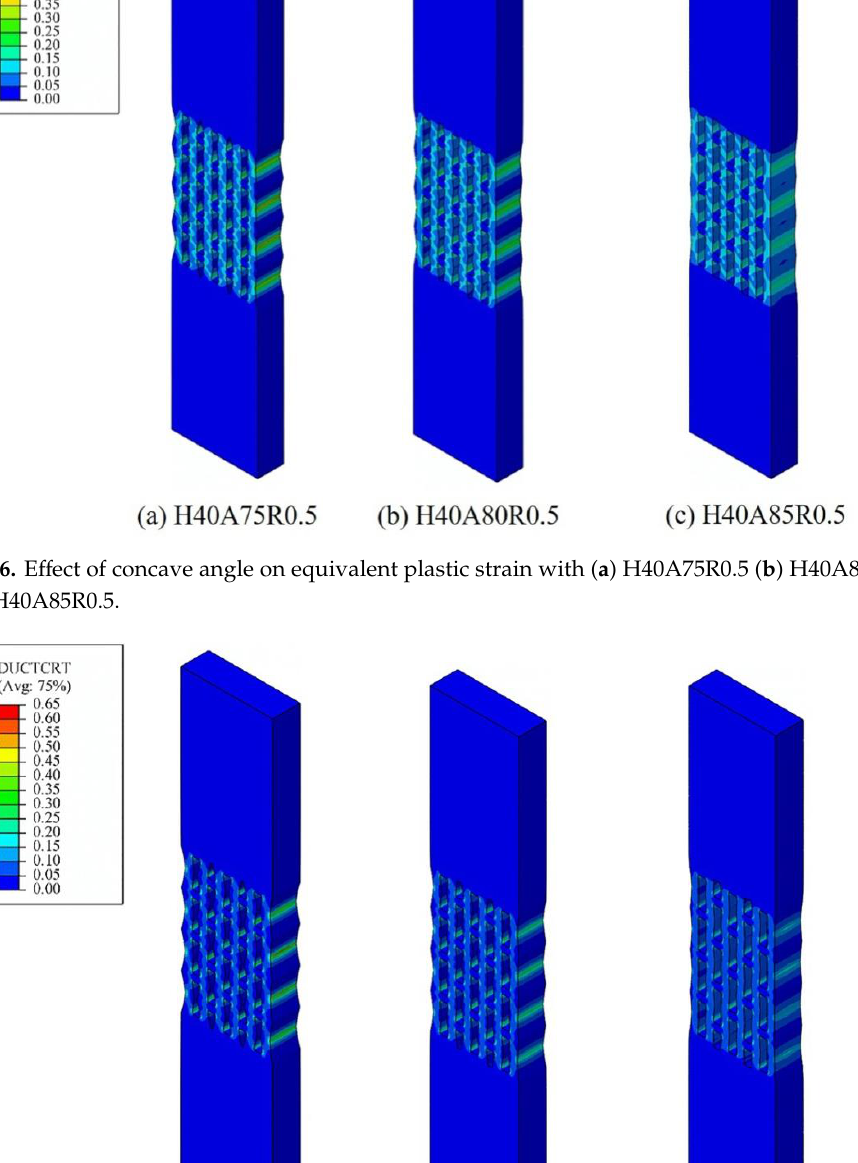
Figure 15. Effect of concave angle on stress triaxiality with (a) H40A75R0.5 (b) H40A80R0.5 and (c)H40A85R0.5.